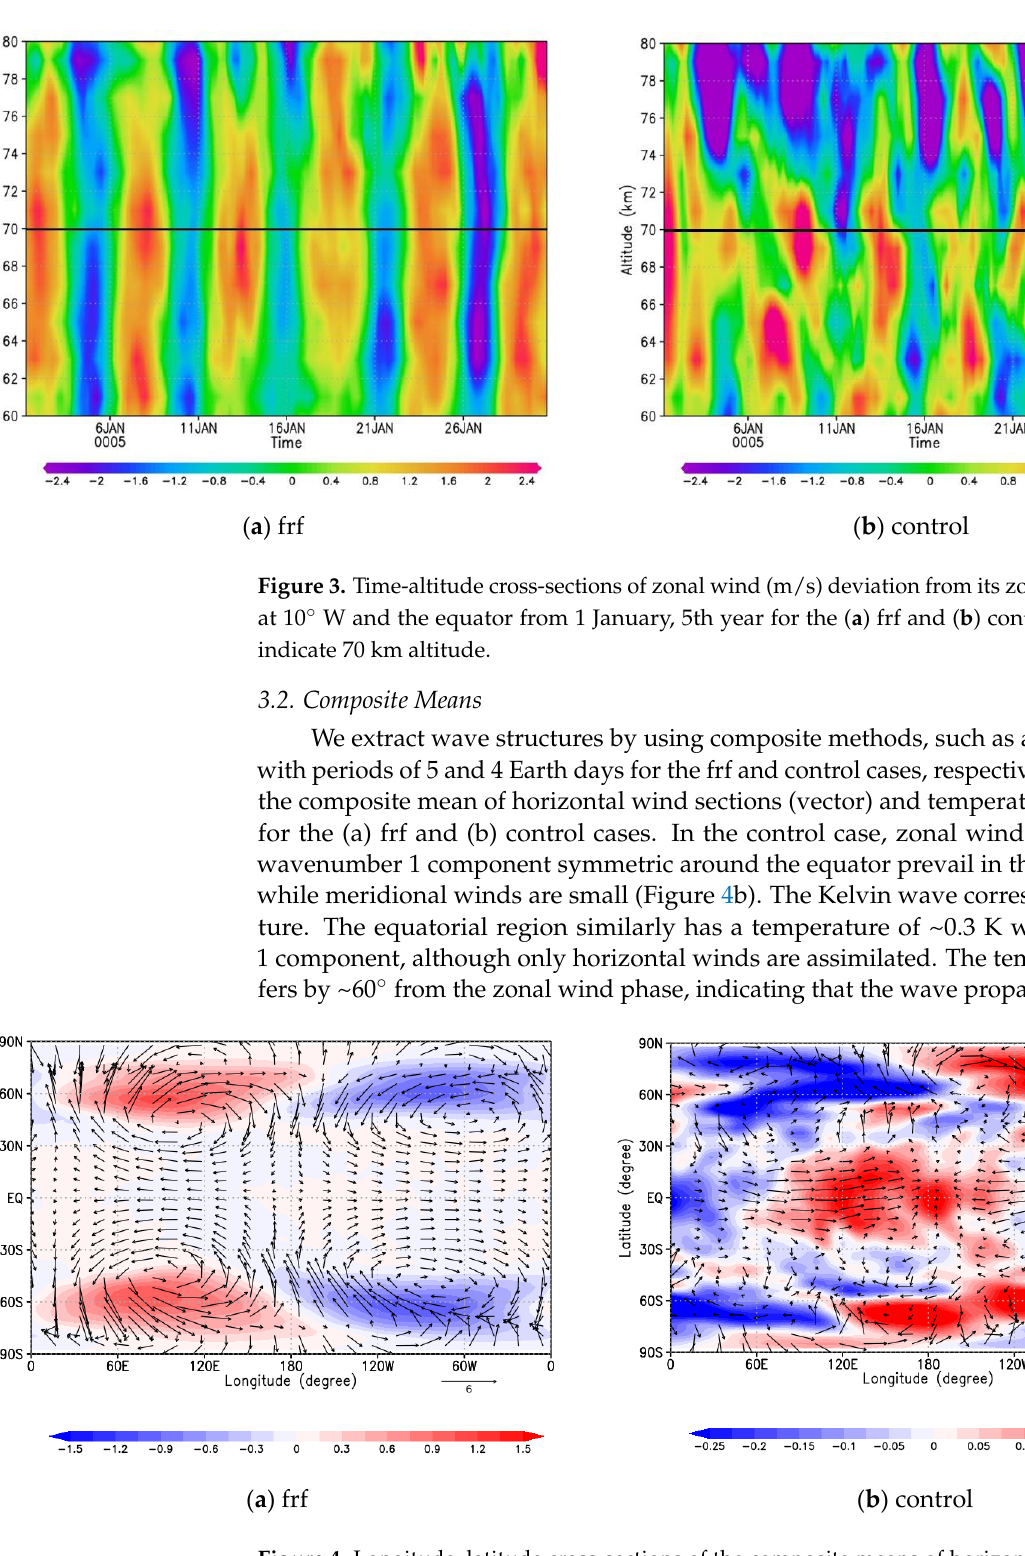
( b ) control Figure 5. Longitude – altitude cross-sections of composite means of zonal wind (m/s; contour) and temperature (K; color) deviations from their zonal averages at the equator for the ( a ) frf and ( b ) control cases. Each field is averaged along with periods of 5 and 4 Earth days for the frf and control cases to extract the Rossby and Kelvin waves, respectively.